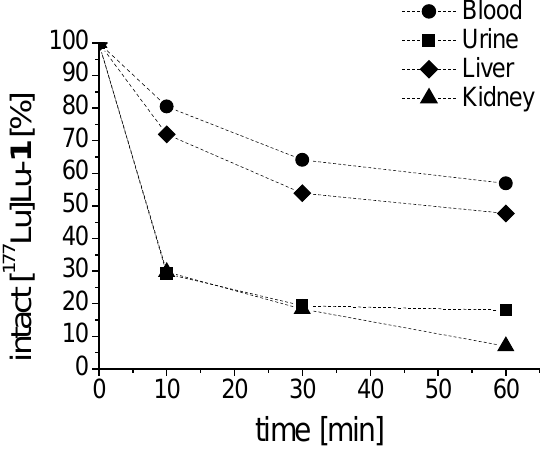
Figure 6. Intact [ 177 Lu]Lu- 1 detectable in blood and urine, as well as liver and kidney homogenates obtained from BALB / c mice, as analyzed up to 60 min p.i.